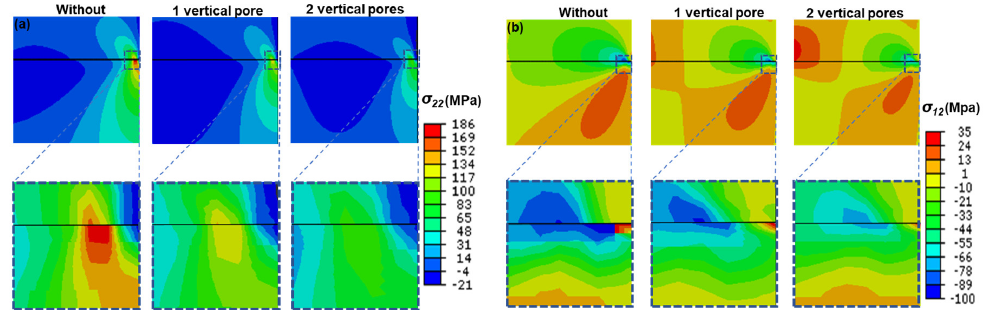
Figure 7. Variation of stress field: ( a ) σ 22 and ( b ) σ 12 at crack tip for 2 mm thickness of TC without, with one vertical pore, and with two vertical pores. The depth of vertical pores was 1.8 mm.